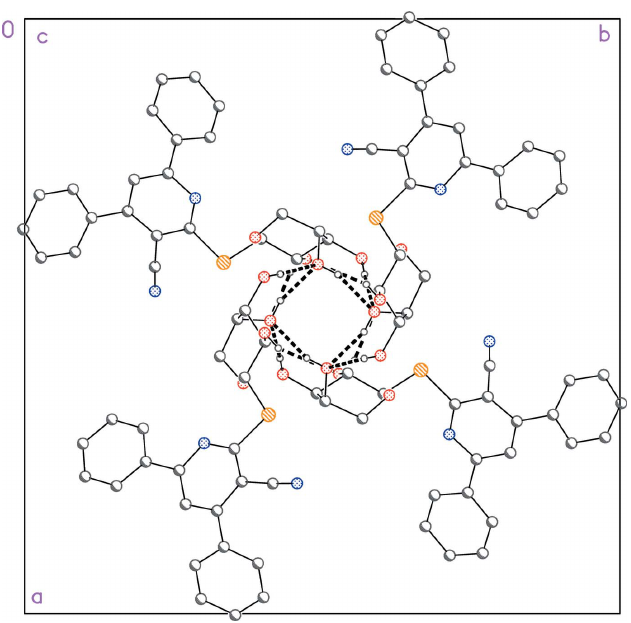
Figure 2 Packing diagram of ( 4 ) projected parallel to the c axis. Dashed lines indicate classical hydrogen